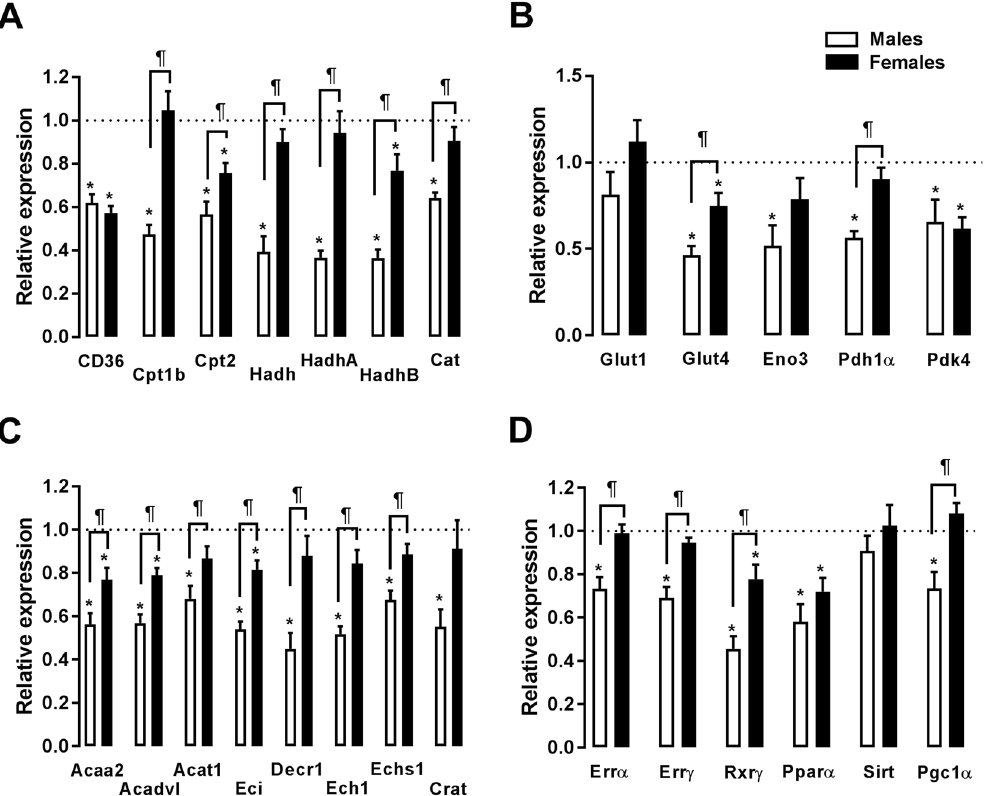
Figure 5. Evaluation by real-time quantitative RT-PCR of the LV mRNA levels of genes encoding for enzymes implicated in fatty acid oxidation (left panels; A and C) and glycolysis (top right panel; B) and for transcription factors related to bioenergetics control (right bottom panel; D). The results are reported in arbitrary units (AU) as the mean ± SEM (n = 5–6/gr.). The mRNA levels of the sham (sham-operated animals) groups (ShM and ShF) were normalized to 1 and are represented by the dotted line. White columns represent the ArM group, and black columns represent the ArF group. * p < 0.05 vs. the corresponding sham group and ¶ p < 0.05 between the ArM and ArF